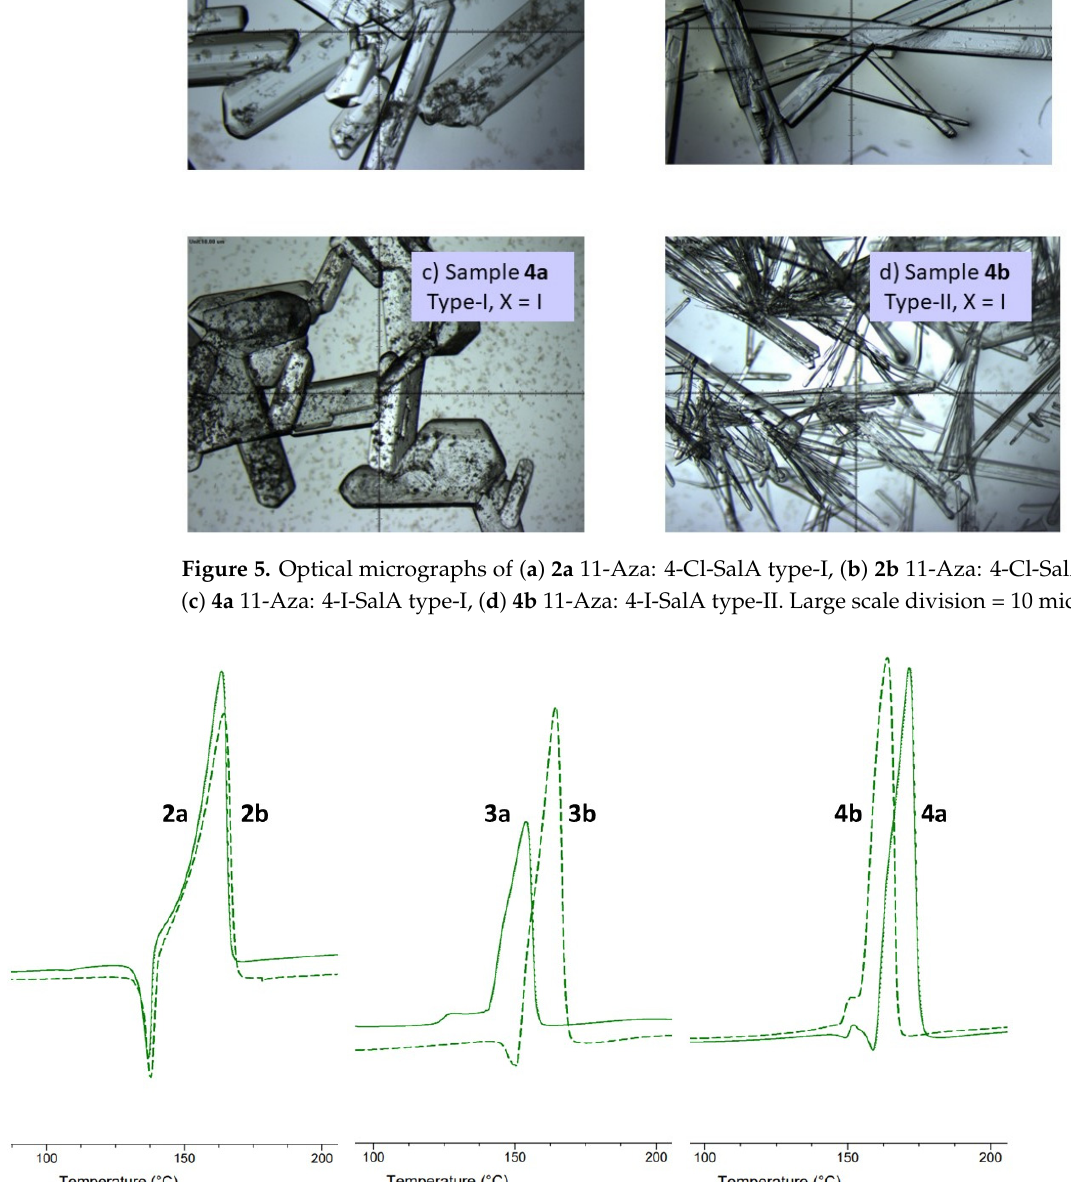
Figure 6. Differential scanning calorimetry (DSC) scans for phases 2–4 comparing ( a ) type-I (solid line) and ( b ) type-II (dashed line) forms.